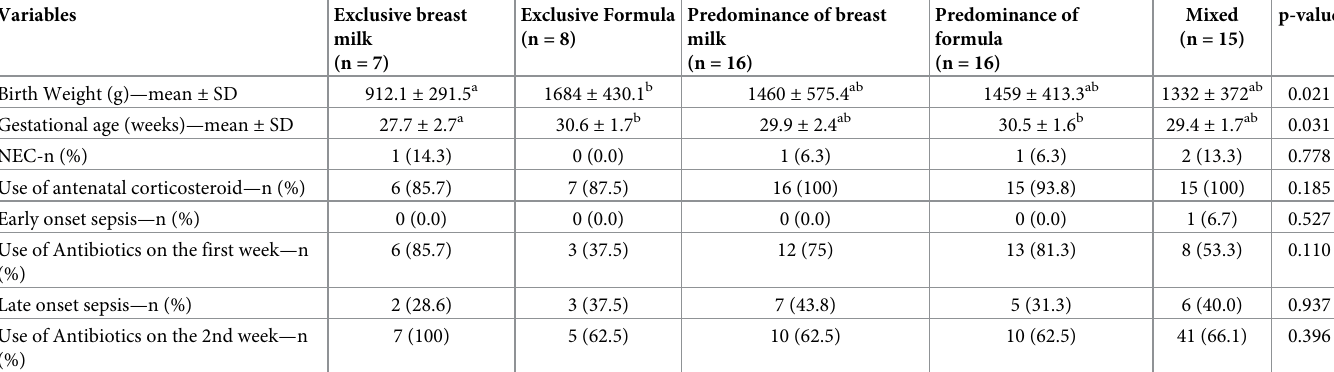
Table 2. Neonatal data according to study